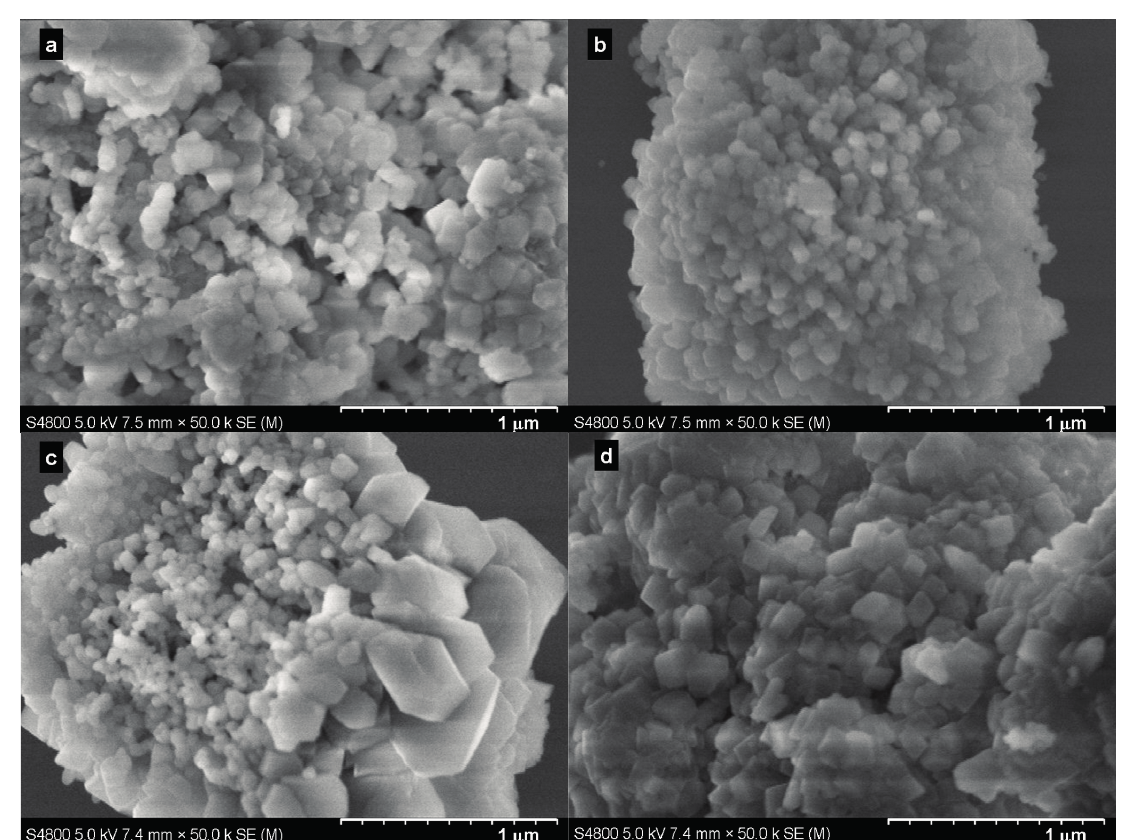
Figure 4. SEM images of samples produced with Bmim[Br] at ( a ) 0.1 MPa; ( b ) 1.0 MPa; ( c ) 5.0 MPa and without Bmim[Br] at ( d ) 5.0 MPa in 5 min at 30.0